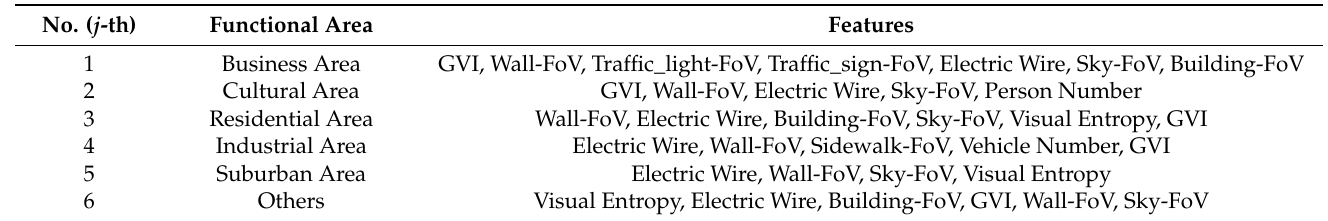
Table 2. The visual features correlated to different functional areas. Each area also has a safety